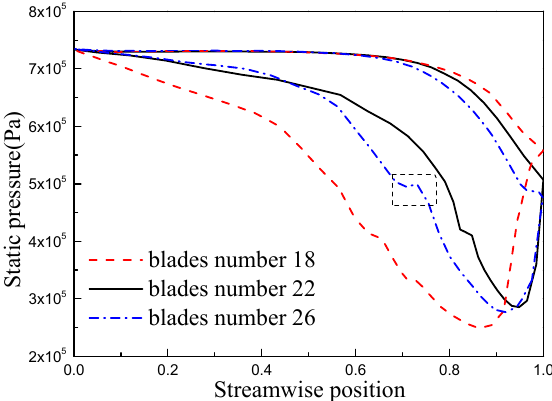
Figure 8. Static pressure distribution along the nozzle blade surface with installation angle 32°.